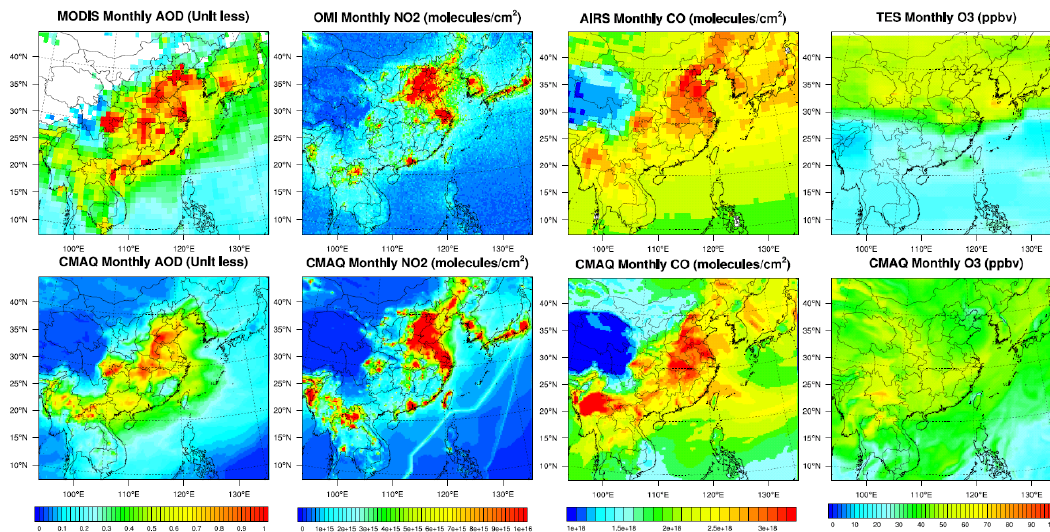
Figure 5. The same as Figure 4, but for monthly average comparison. Fig. 5. The same as Fig. 4, but for monthly average